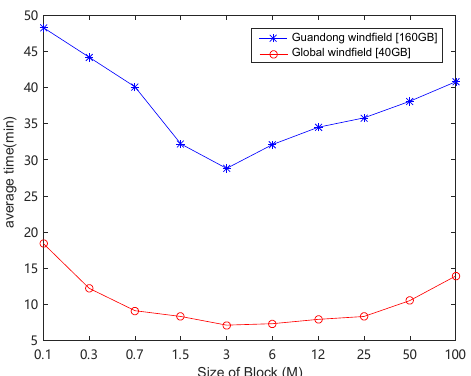
Figure 11. The effect of block size on the overall computing efficiency. It can be seen that when the block size was about 3 M, the frame had better performance. When data were greater than or less than 3 M, the increase or decrease of data led to lower performance.